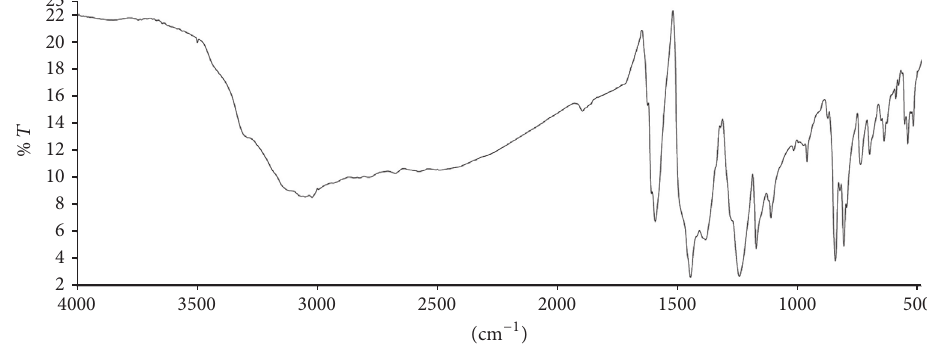
Figure 3: FTIR spectrum of HPBI.